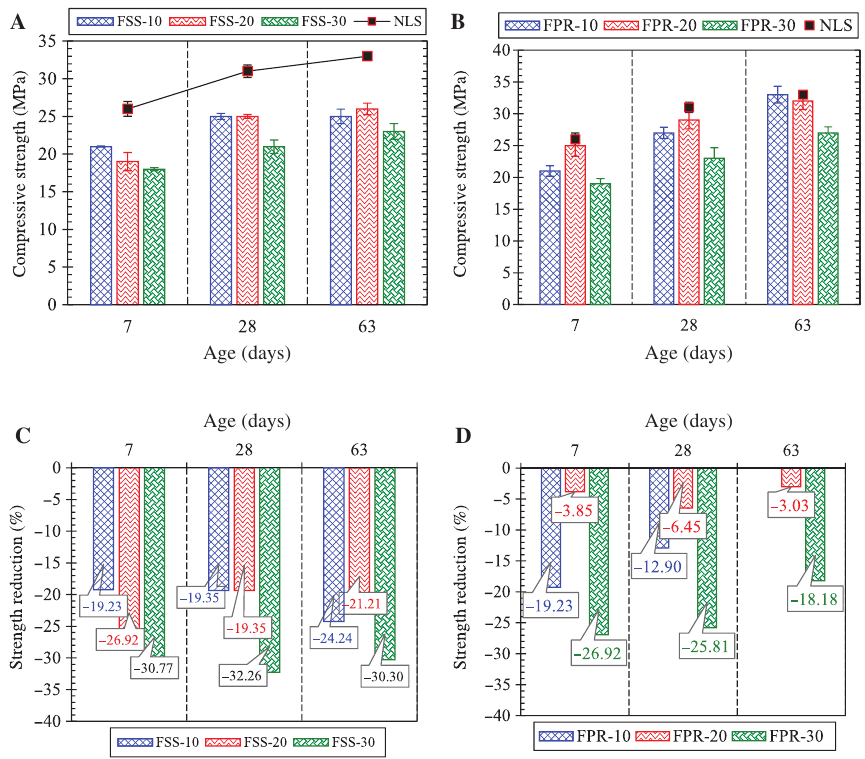
Figure 7: Compressive strength of concrete at various ages. (A) FSS and NLS specimens, (B) FPR and NLS specimens, (C) strength reduction of FSS specimens and (D) strength reduction of FPR